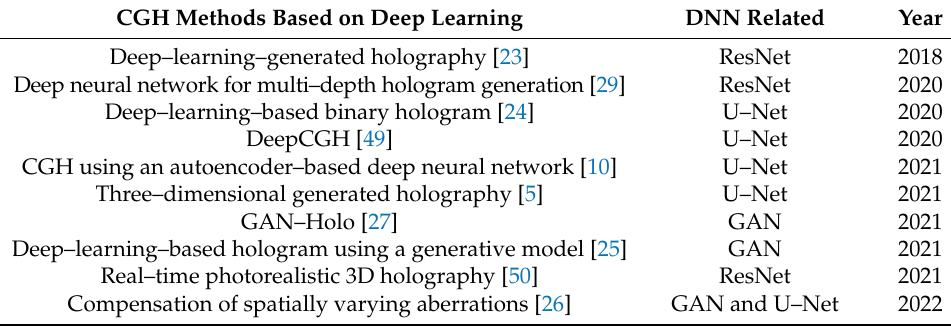
Figure 5. Development and application of CGH based on DNN in recent years. Table 1. DNN used in CGH based on deep learning.